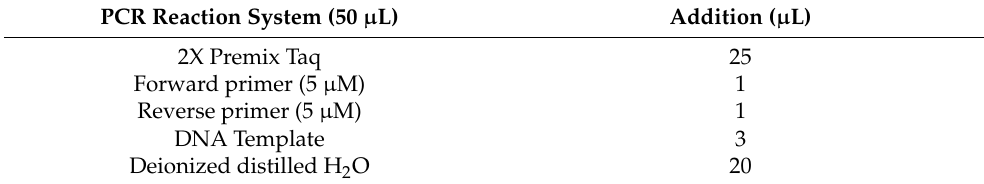
Table 1. PCR reaction components system.